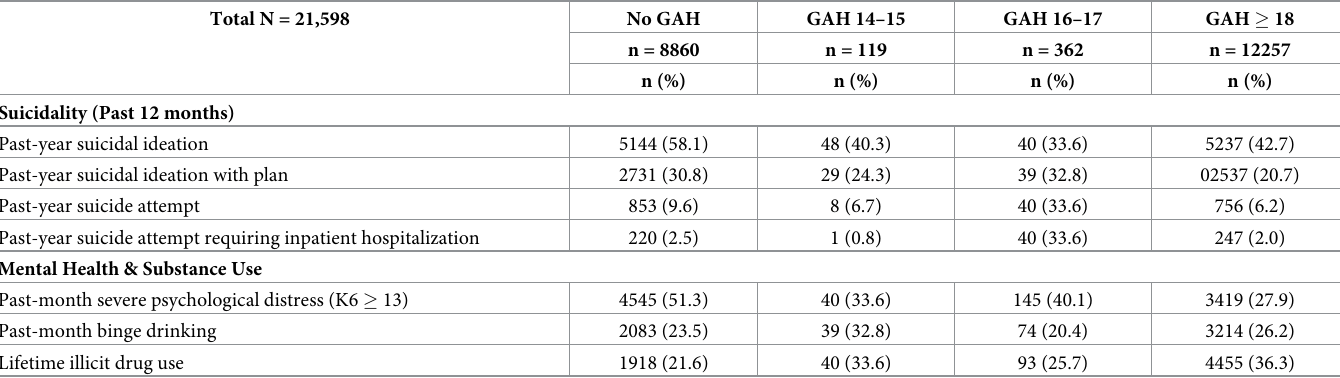
Table 3. Raw outcome frequencies of mental health outcomes.